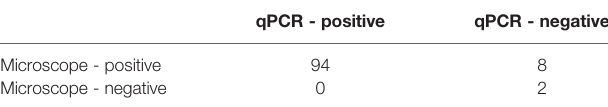
TABLE 2 | Contingency table of methodological comparison between microscope smears and qPCR. qPCR - positive qPCR - negative Microscope -